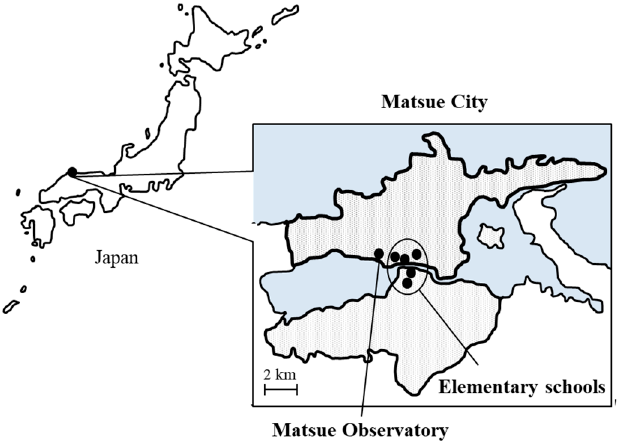
Figure 1. The spatial distributions of air monitoring sites and elementary schools in Matsue, Japan.